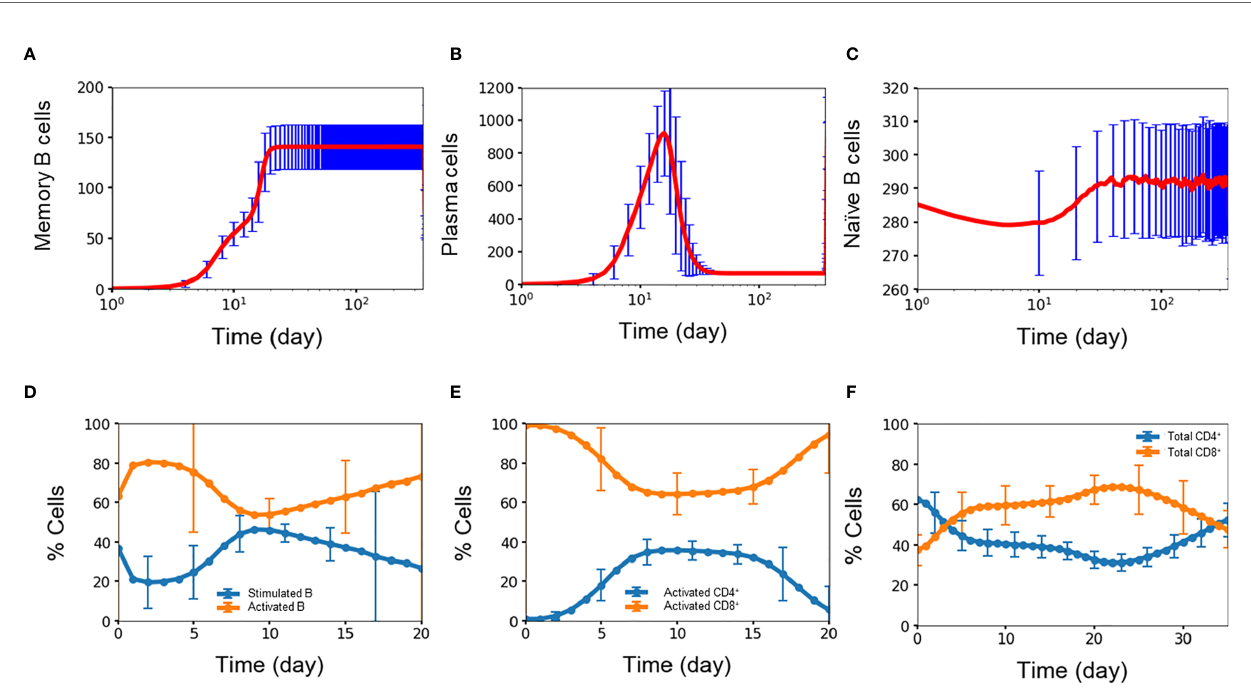
FIGURE 3 | Concentration (n units x 10 3 /ml) of (A) memory B cell, (B) plasma B cell, (C) naïve B cell, percentage of (D) stimulated B cell and activated B cell, (E) CD4 + T cell and CD8 + T cell, (F) activated CD4 + T cell and activated CD8 + T cell concentration as a function of time during primary infections. Average values from 10,000 independent simulations are shown, error bars are shown as the standard